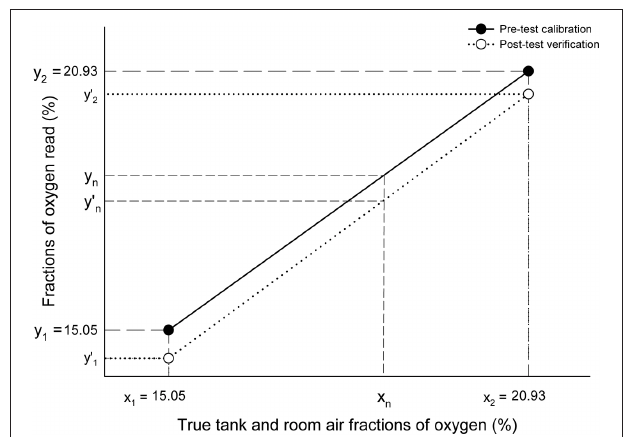
FIGURE 1 | Correction of fractional concentrations of oxygen. x 1 and x 2 , true tank ( x 1 = 15.05 %) and room air ( x 2 = 20.93 %) fractions of oxygen; y 1 and y 2 , fractions of tank ( y 1 = 15.05 %) and room oxygen ( y 2 = 20.93 %) read by the analyzer during the pre-test calibration process when the true